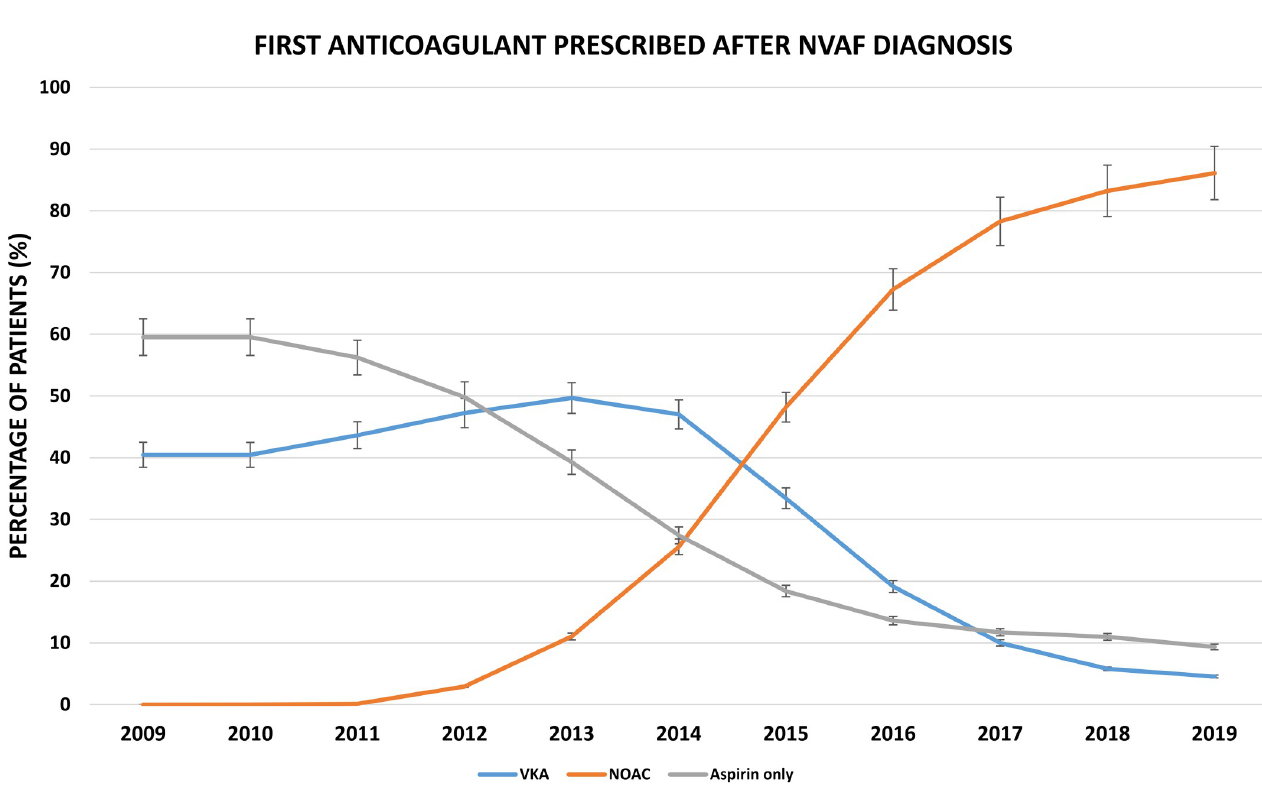
Fig 5. Proportion of patients prescribed first treatment after NVAF diagnosis and 95% CI stratified by the type of drug initiated, from 2009 to 2019. CI, confidence interval; NOAC, non- vitamin K antagonist oral anticoagulant; NVAF, nonvalvular atrial fibrillation; VKA, vitamin K antagonist.